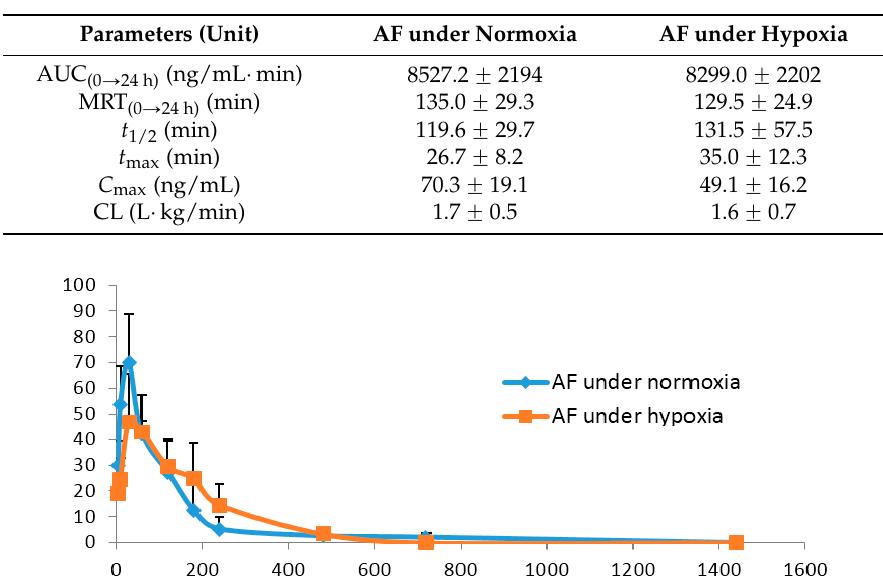
Table 5. The main pharmacokinetic parameters of AF under normoxia/hypoxia in rat plasma after a single intragastrical administration ( n = 6).